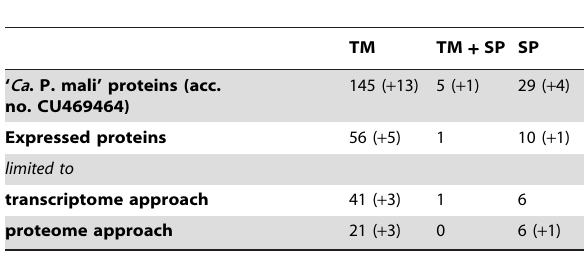
Table 2. Total number of proteins and expressed proteins carrying transmembrane helices (TM), TM and a signal peptide (SP) or